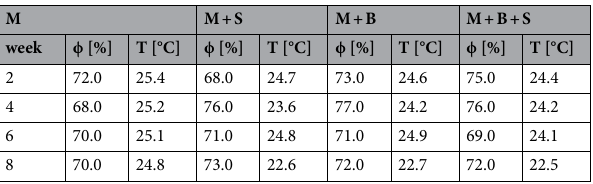
Table 2. Relative air humidity (ϕ) and temperature (T) of manure variants during maturation.